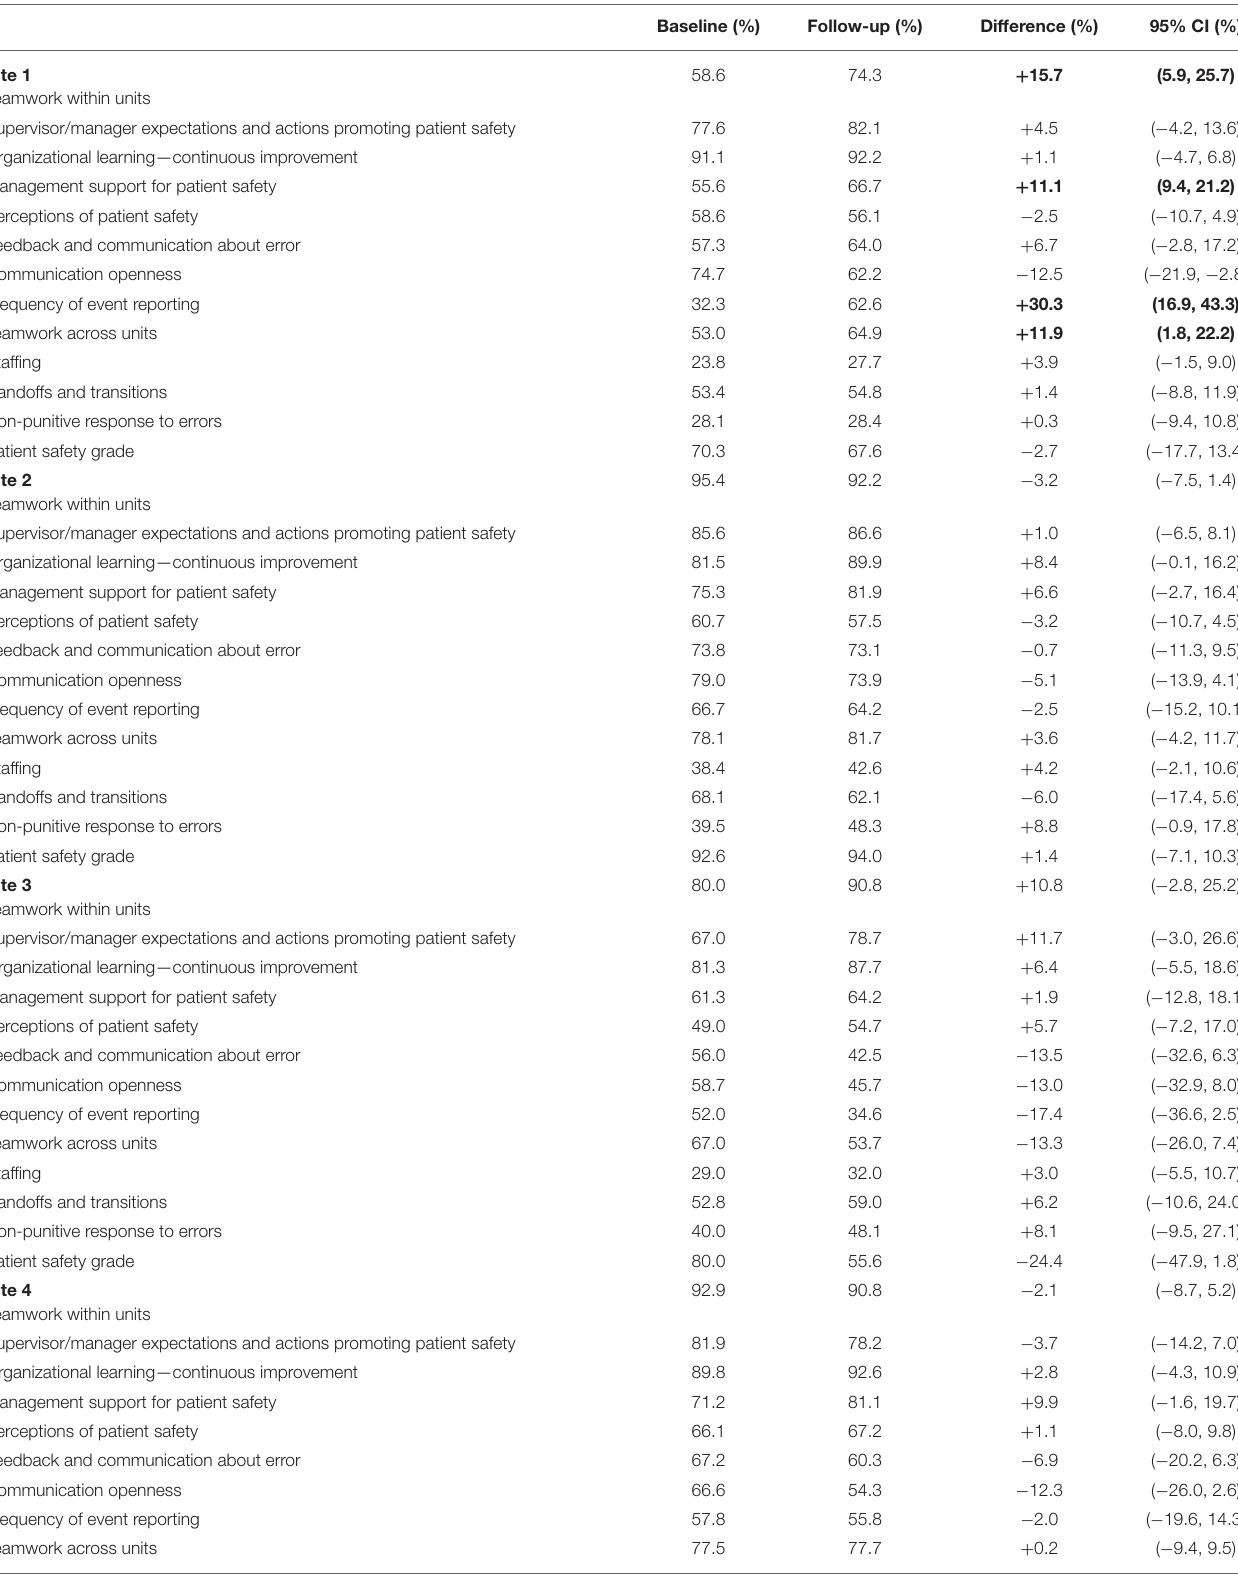
Baseline (%) Follow-up (%) Difference